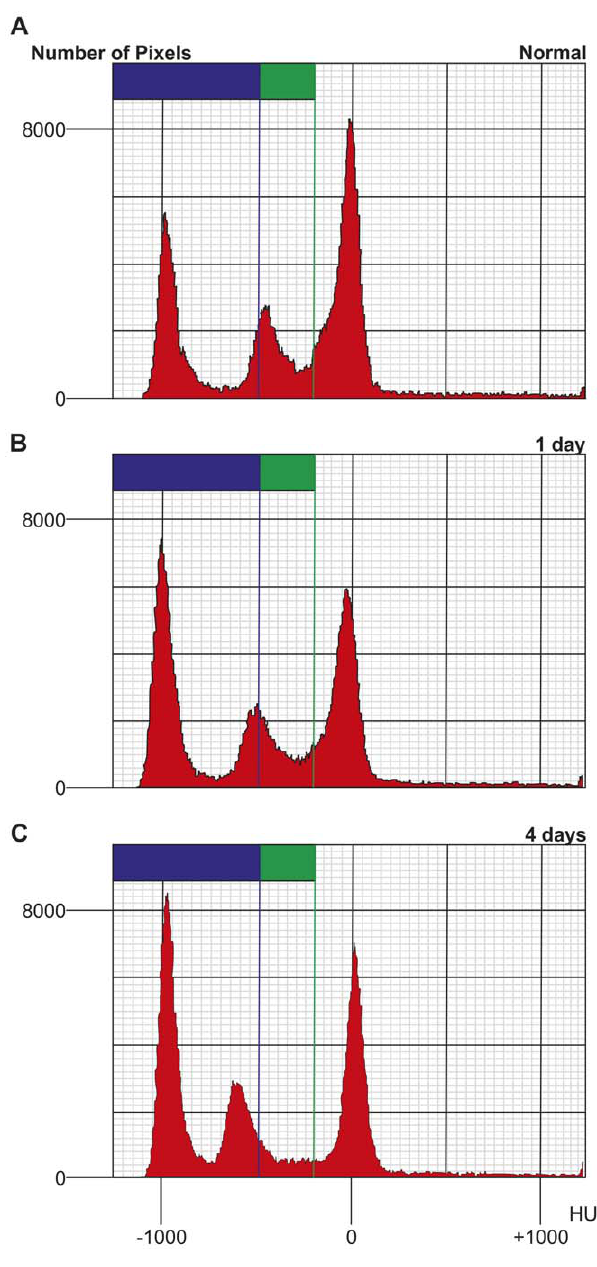
Figure 2. HU analysis. (A)Typical histograms of micro-CT in normal, (B) Radiation-induced mice lung injury at 1 day (X1), and (C) Radiation- induced mice lung injury at 4 days, after x-ray exposure (X4). Areas of high density (between 2 200 to 2 500 HU) in three-dimensional Micro- CT slices are shown in green, and areas of low density (below 2 500 HU) are shown in